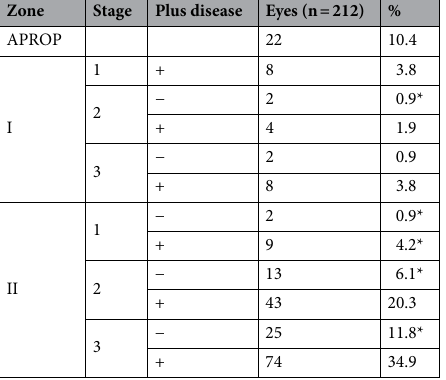
Table 2. ROP advancement at the time of treatment decision in inborn patients, in the years 2016–2019. * treatment applied outside ETROP criteria, on the decision of ophthalmologist.